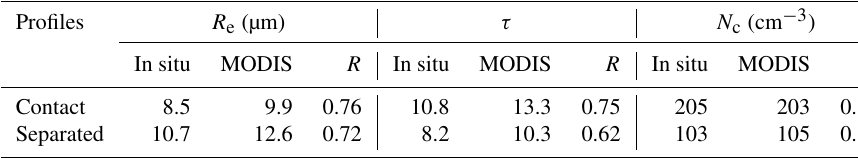
Table 5. The average in situ and MODIS R e , τ , and N c for contact and separated profiles, along with R